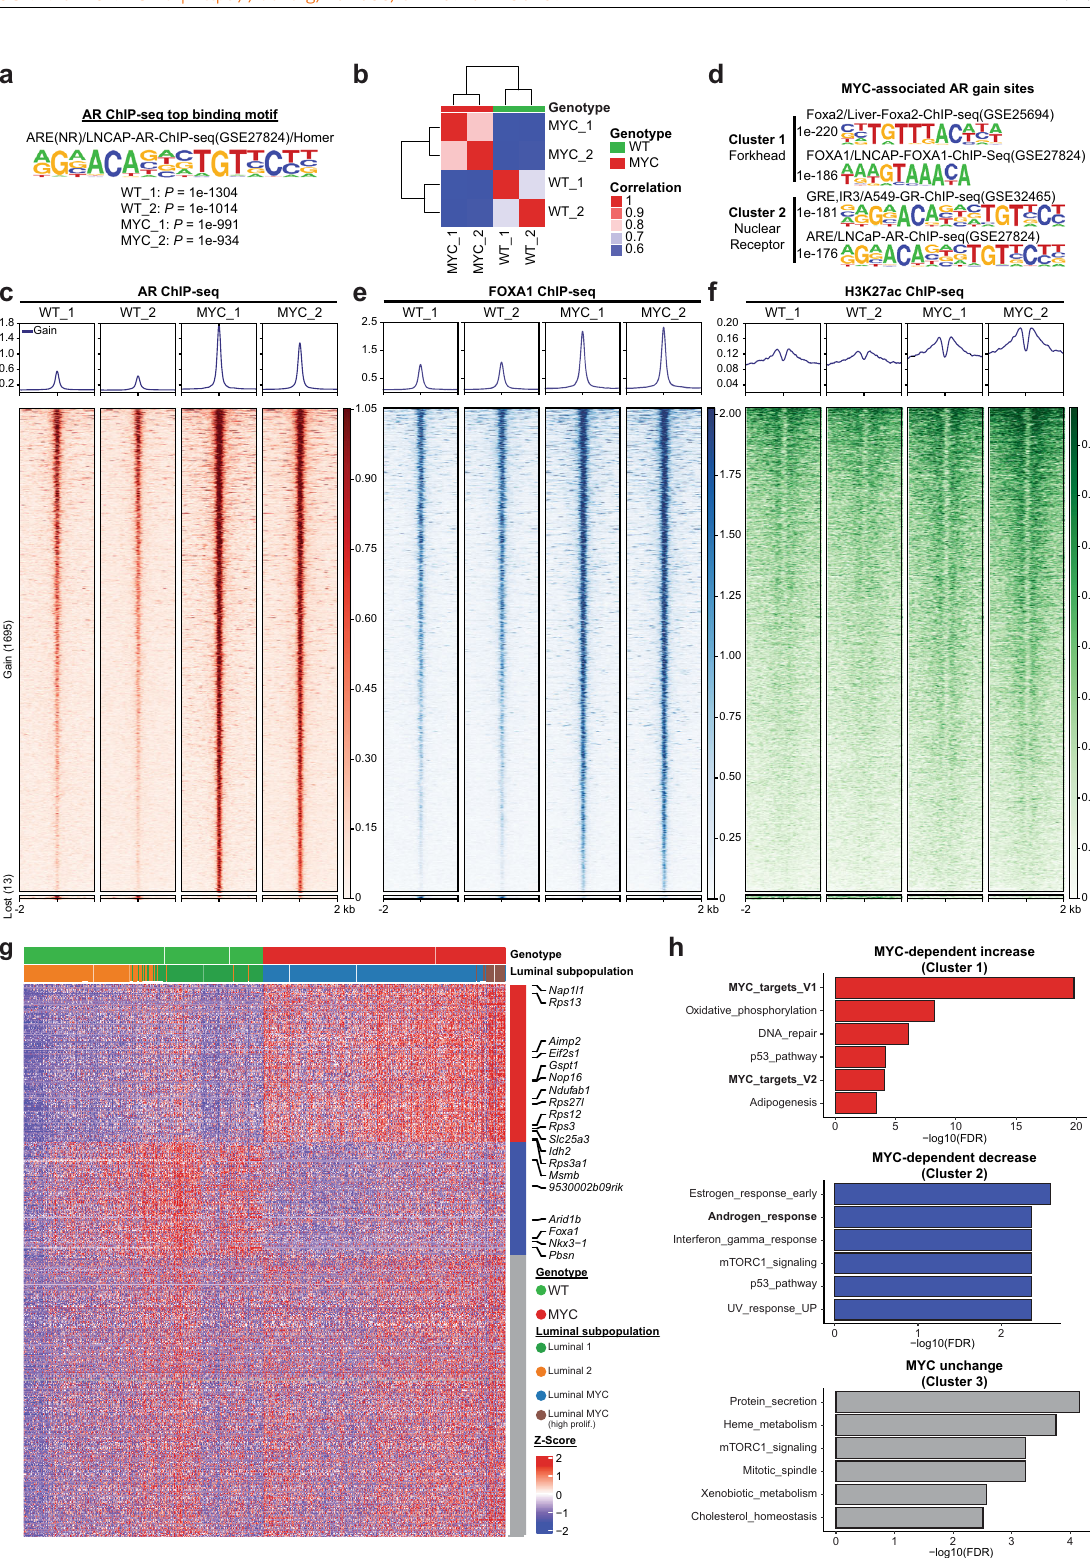
CorrelationGenotype WT MYC